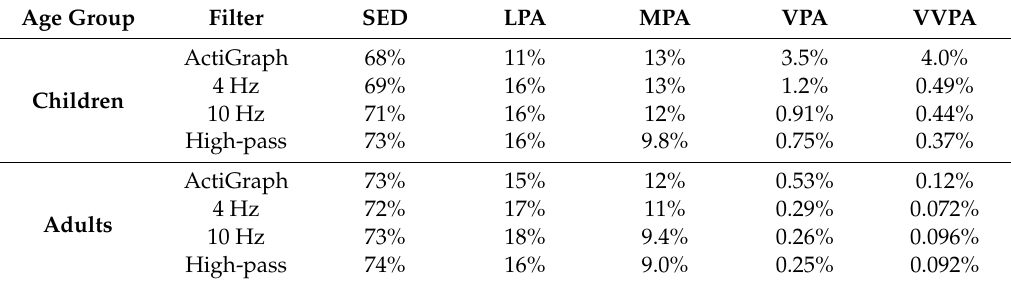
Table 2. Distribution of mean time spent at di ff erent intensities between 06.00 and 23.00. Age